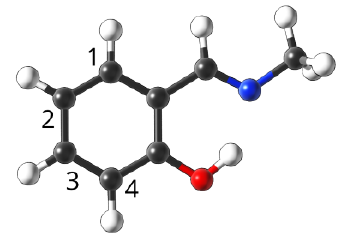
Figure 10. Base compound used to test the empirical model, with substitution sites indicated by